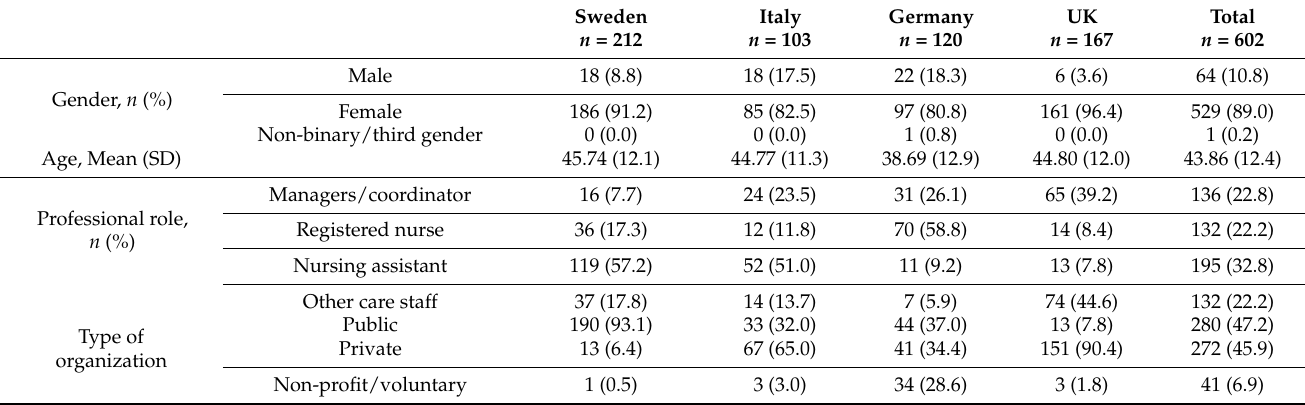
Table 1. Description of